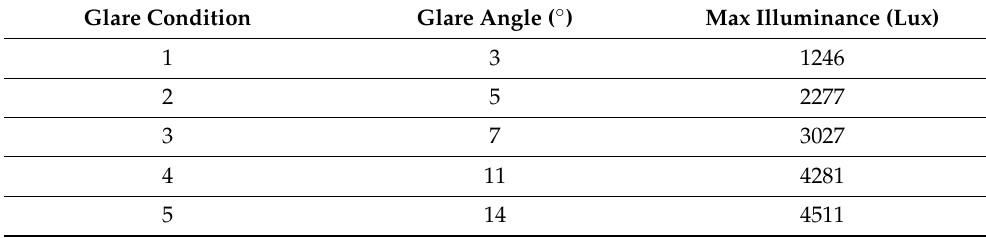
Figure 1. ( a ) Schematic of the experimental optical bench. ( b ) Test visual stimulus for different Michelson contrast levels and constant spatially averaged luminance. Table 1. Maximum glare angle and illuminance entering the pupil of the